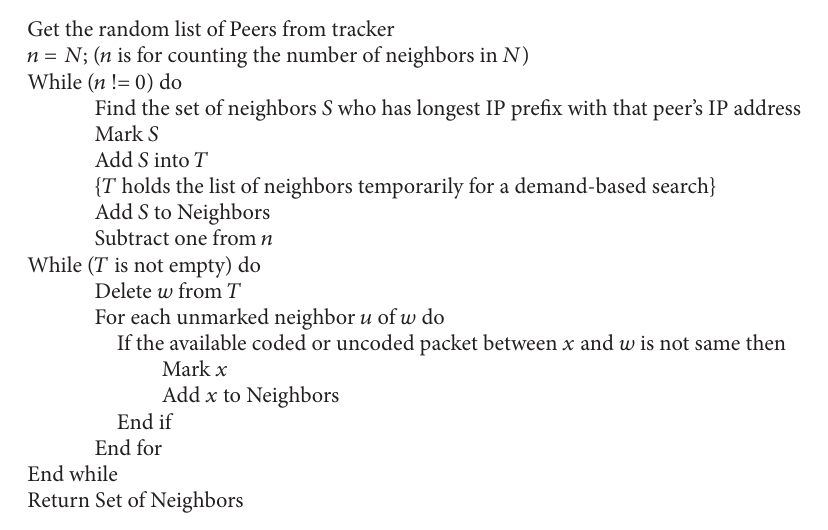
Pseudocode 1: Pseudocode for neighbor